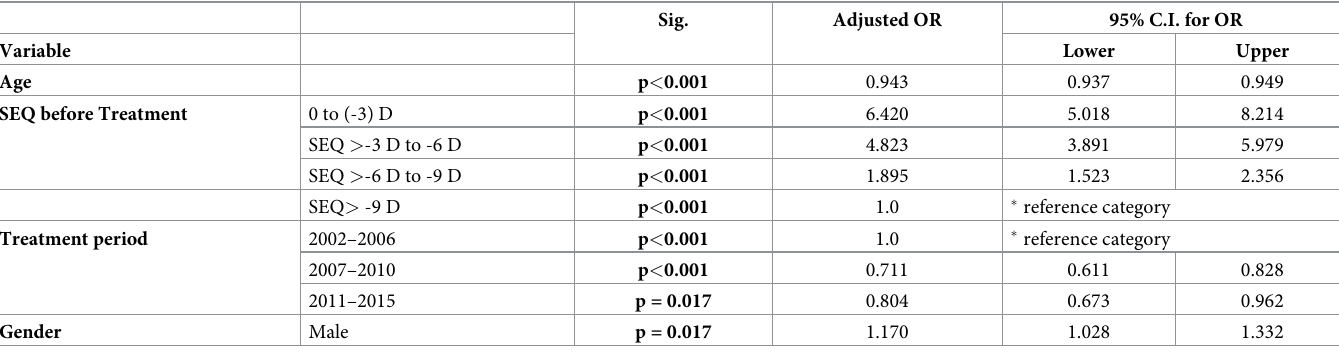
Table 11. Logistic regression model–efficacy.